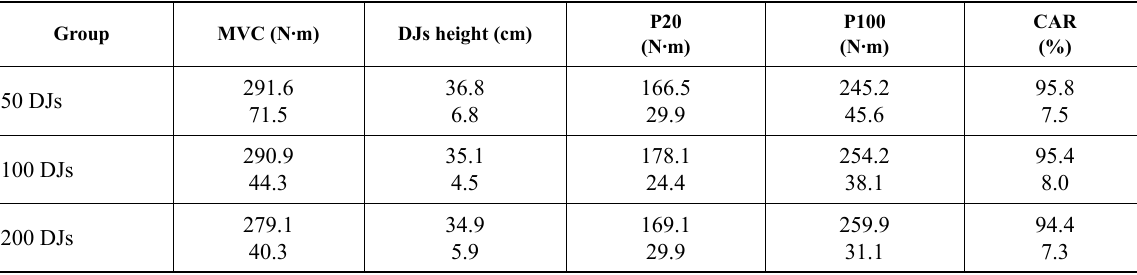
Table 1. Pre-exercise values of muscle torque and power indices (mean ± SD)